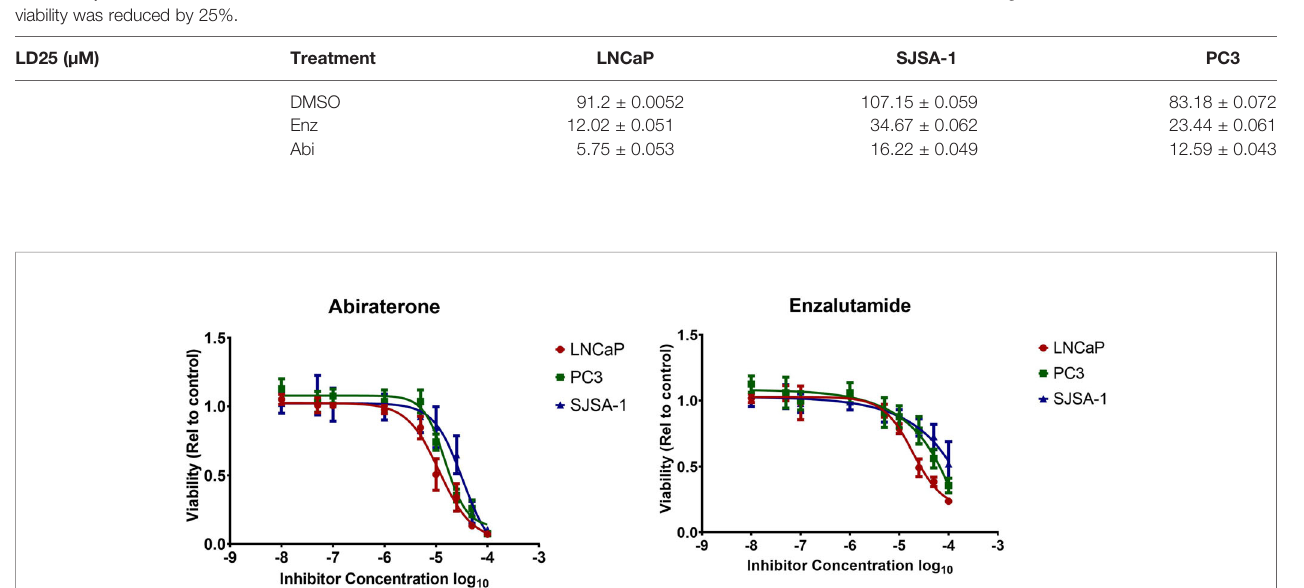
FIGURE 2 | Comparison of Abiraterone and Enzalutamide treatment on cell viability of androgen-sensitive (LNCaP), androgen-resistant (PC3) prostate cancer models and osteoblastic bone model (SJSA-1). LNCaP, PC3, SJSA-1 cells were treated with a dose range of 10 nM to 100 m M of Abiraterone and Enzalutamide or DMSO. Cell viability was evaluated 72 hours post-treatment by MTT assay. Each value is the mean of three independent experiments performed in triplicate (errors represent SEM).